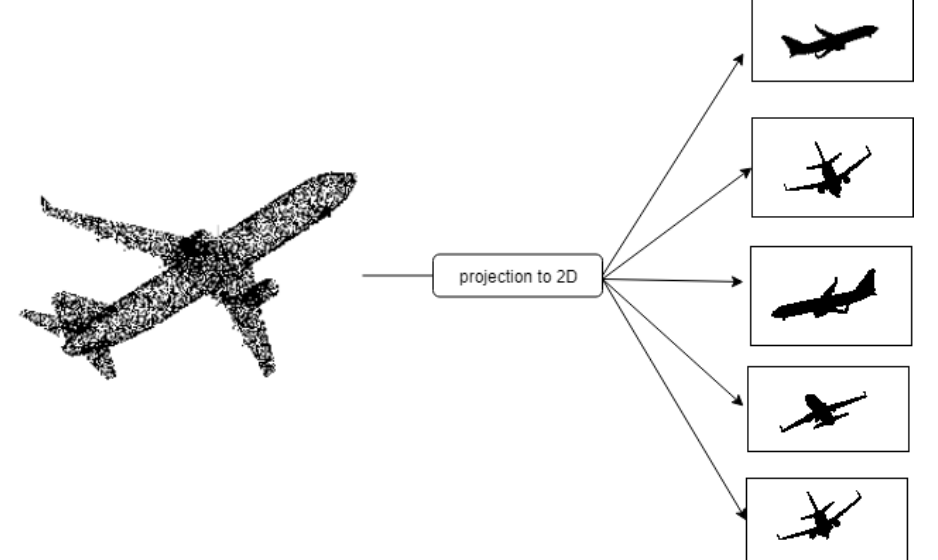
Figure 5. Multi-view projection of a point cloud to 2D images. Each 2D image represents the same object viewed from a different